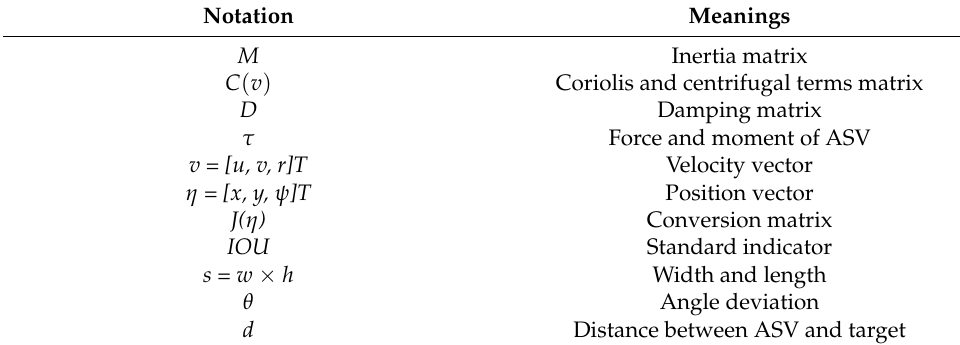
Figure 2. The main flow of our proposed algorithm. Table 1. Notations used in this paper.